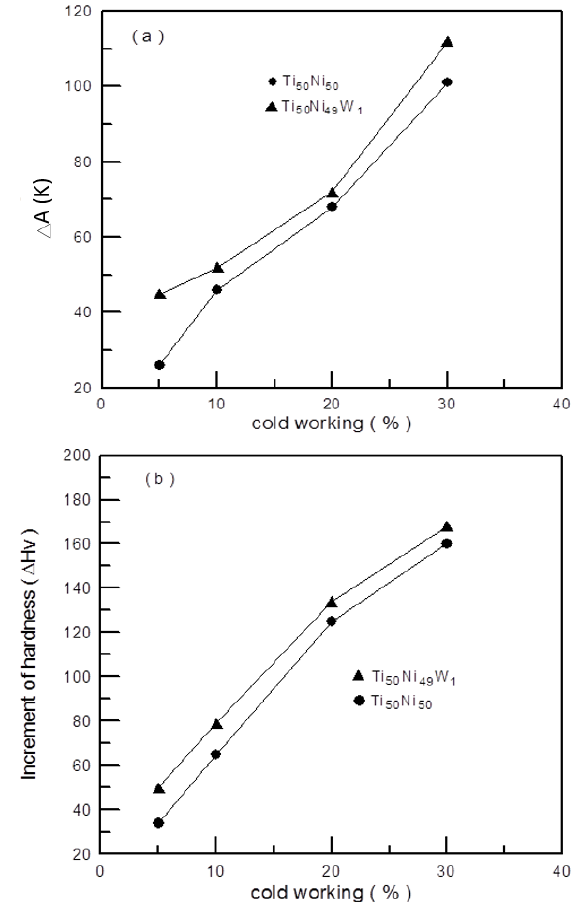
Figure 8. Martensite stabilization represented by the difference between the peak temperature A 1* and A 2* ( ∆ A *). ( a ) ∆ A * and ( b ) the increase in hardness of the Ti 50 Ni 49 W 1 and Ti 50 Ni 50 alloy [32] after 5–30% cold rolling.